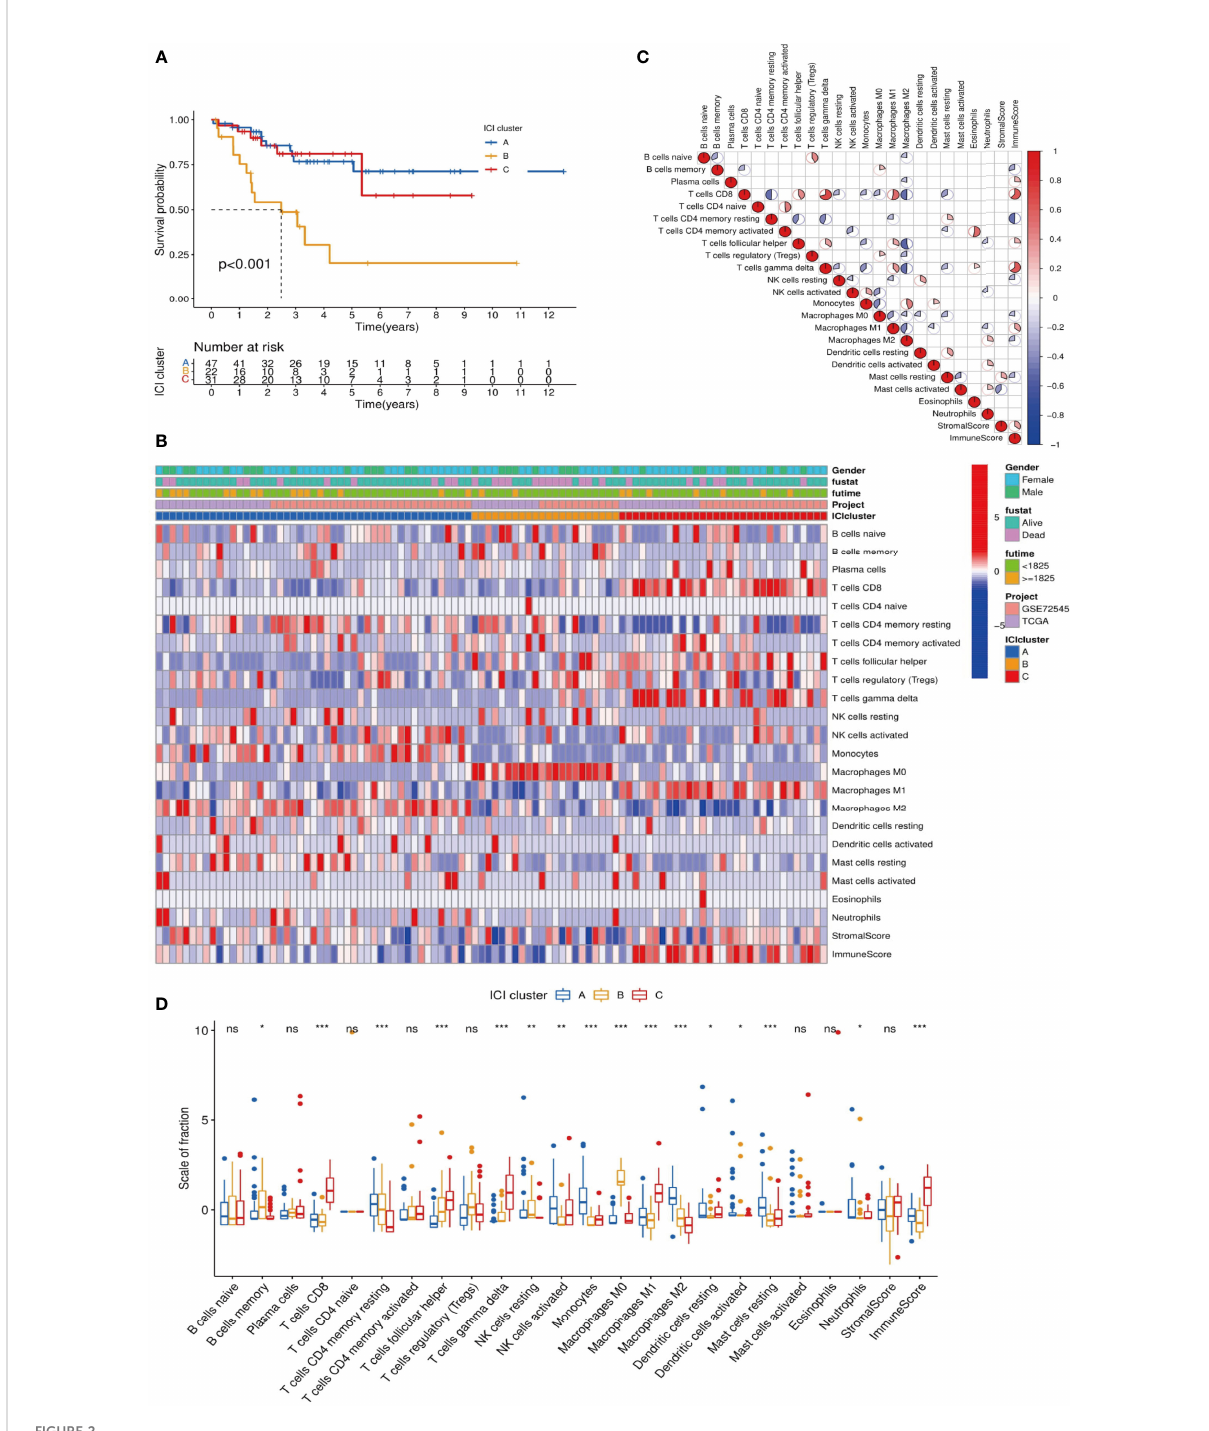
FIGURE 2 Analysis of differences among ICI subtypes and immune in fi ltration characteristics. (A) We analyzed the difference in Overall Survival (OS) among the 3 ICI subtypes and visualized the details via a K-M survival curve: compared with ICI cluster A and ICI cluster C, the OS of ICI cluster B was signi fi cantly lower, p <0.001; (B) Unsupervised cluster analysis was used to analyze the distribution of immune in fi ltration characteristics in MFS samples. The abscissa represents the immune in fi ltrating characteristics, and the ordinate represents independent samples; (C) We explored the relationships among 24 immune in fi ltrating characteristics (22 kinds of immune in fi ltrating cells and Stromal/Immune Score): red indicated a positive correlation, and blue indicated a negative correlation. The higher the correlation, the larger the pie chart area; (D) The differences in expression of 24 immune in fi ltration characteristics in 3 ICI subtypes are visualized in a box plot: ***p <0.001, **p <0.01, and *p <0.05 ns p>0.05,no signi fi